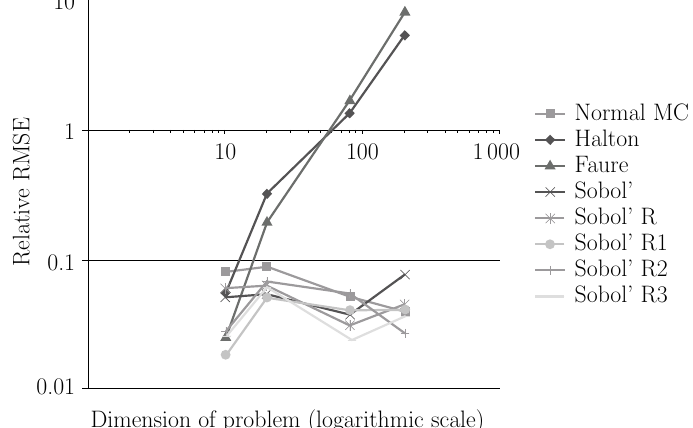
Figure 4: RRMSE for different RLDSs over increasing sizes of the